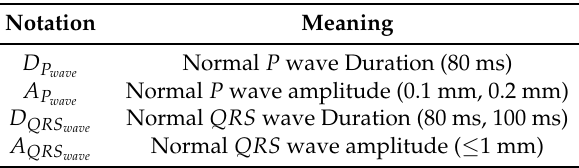
Table 1. Normal values for waves [46,47].